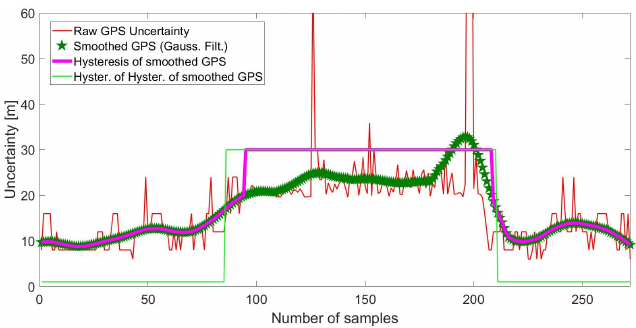
Figure 5. GPS uncertainty data from five outdoor–indoor transitions (OITransitions). As can be seen, at the moment of the transition after the 100th sample, the uncertainty rapidly increased.